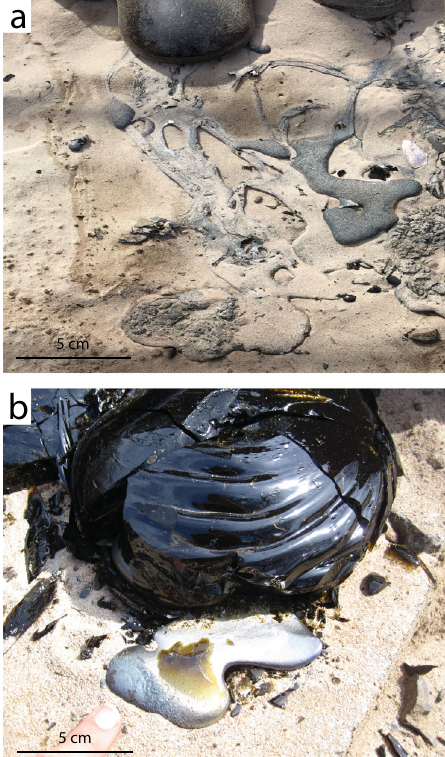
Fig. 3 Metallic fl ow breakout morphologies. a Early metallic fl ow braided breakout (silver) from underneath the silicate fl ow front (black). b Late metallic fl ow cohesive breakout (silver) from the silicate fl ow (black)